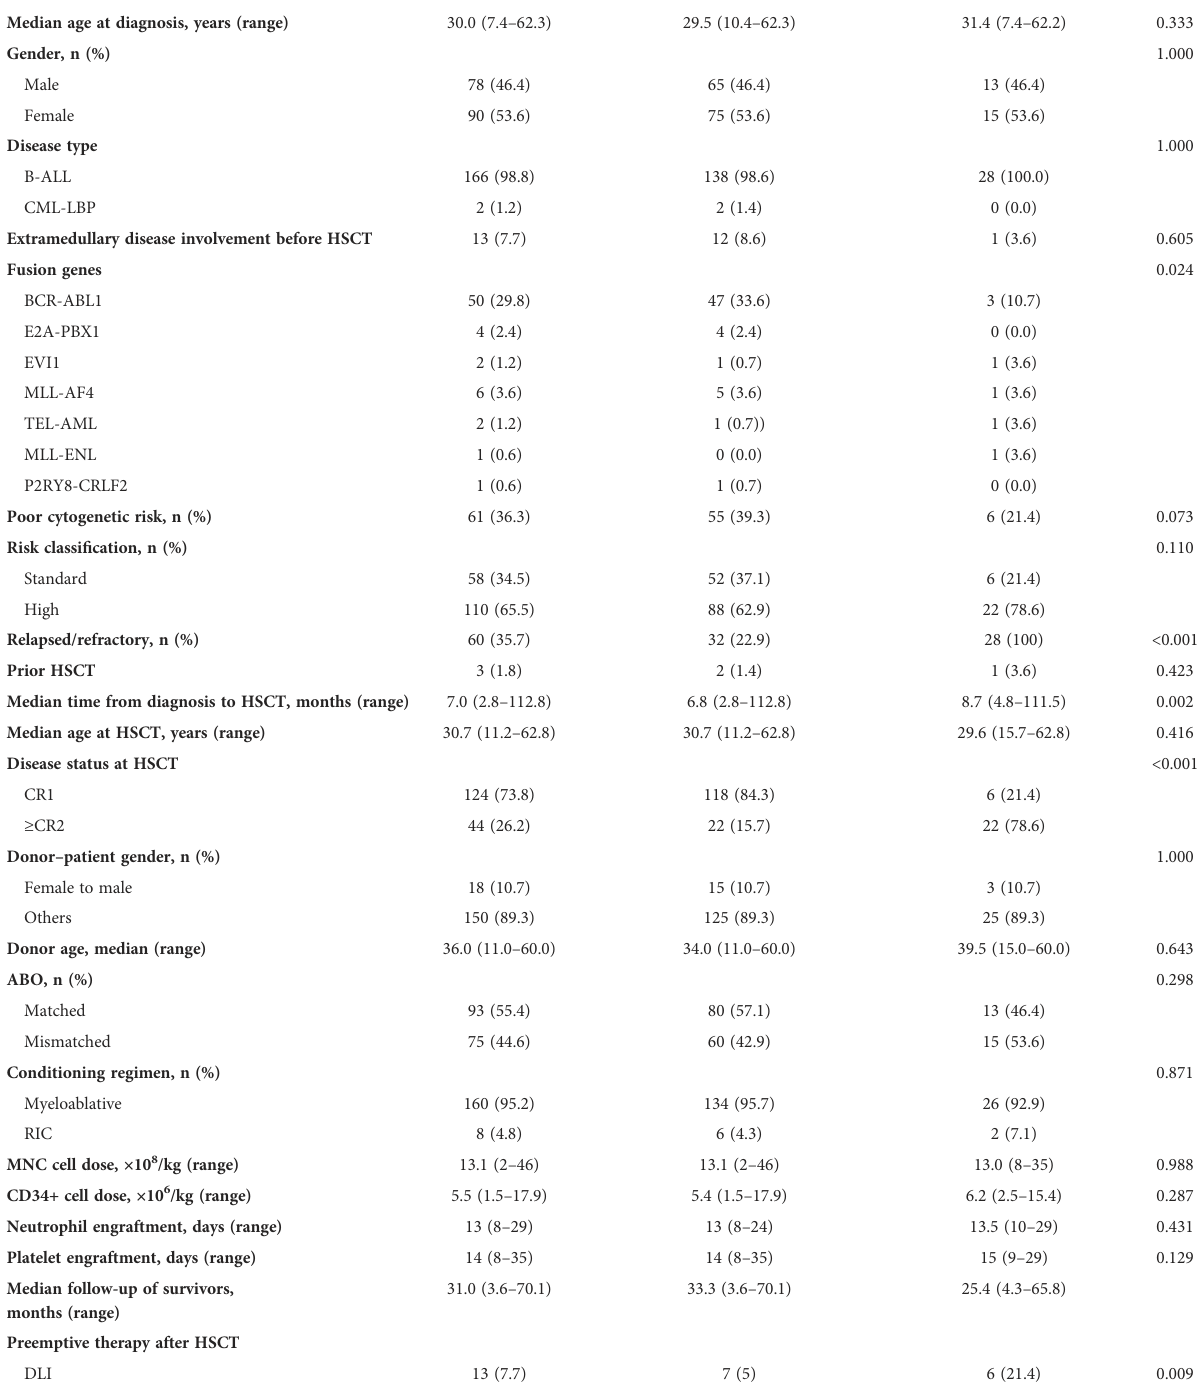
TABLE 1 Baseline and transplant-related characteristics of patients.